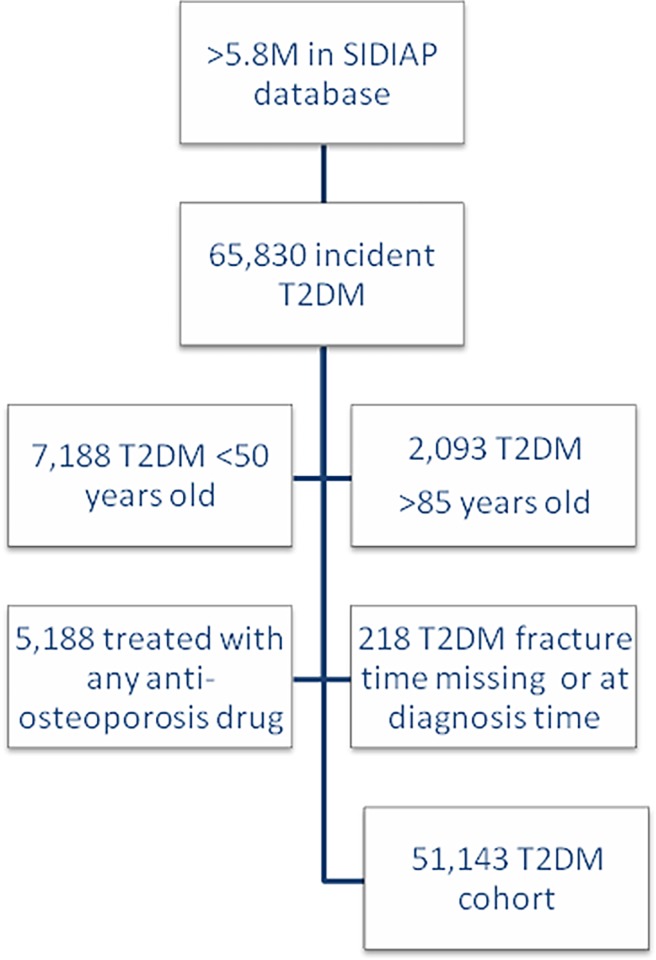
Study flow chart.